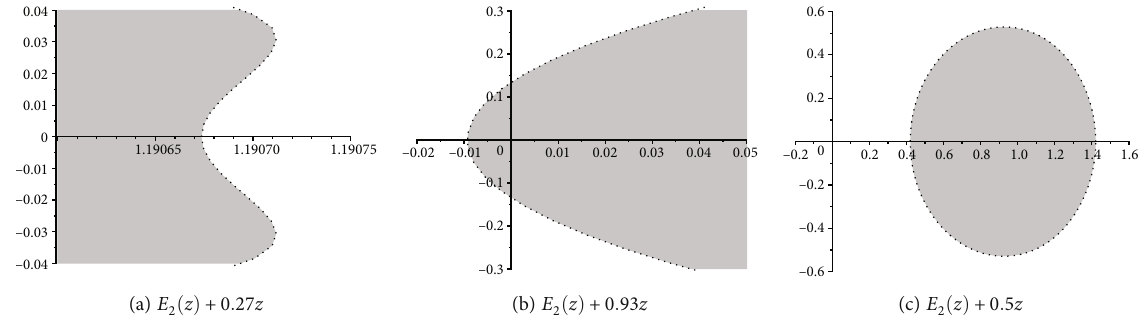
ff erent values of μ